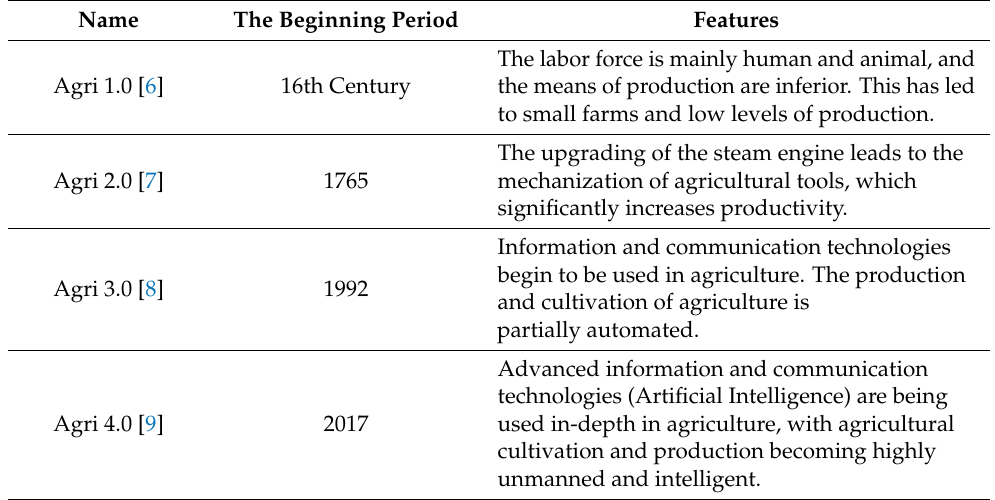
Table 1. The development process of